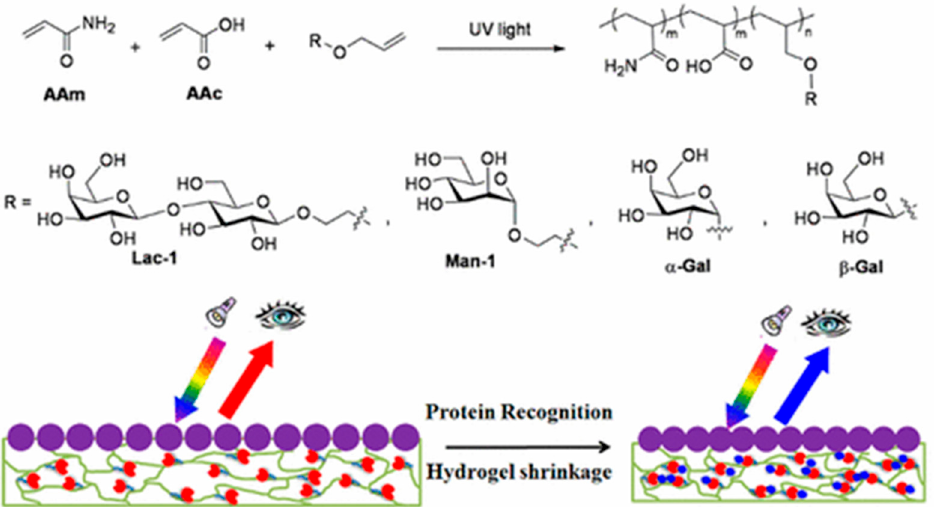
Figure 13. Shrinkage of the carbohydrate-containing hydrogel upon binding of a lectin detected as a change of interparticle distance diffracting visible light. Reproduced with permission from [125]. Copyright American Chemical Society, 2017.